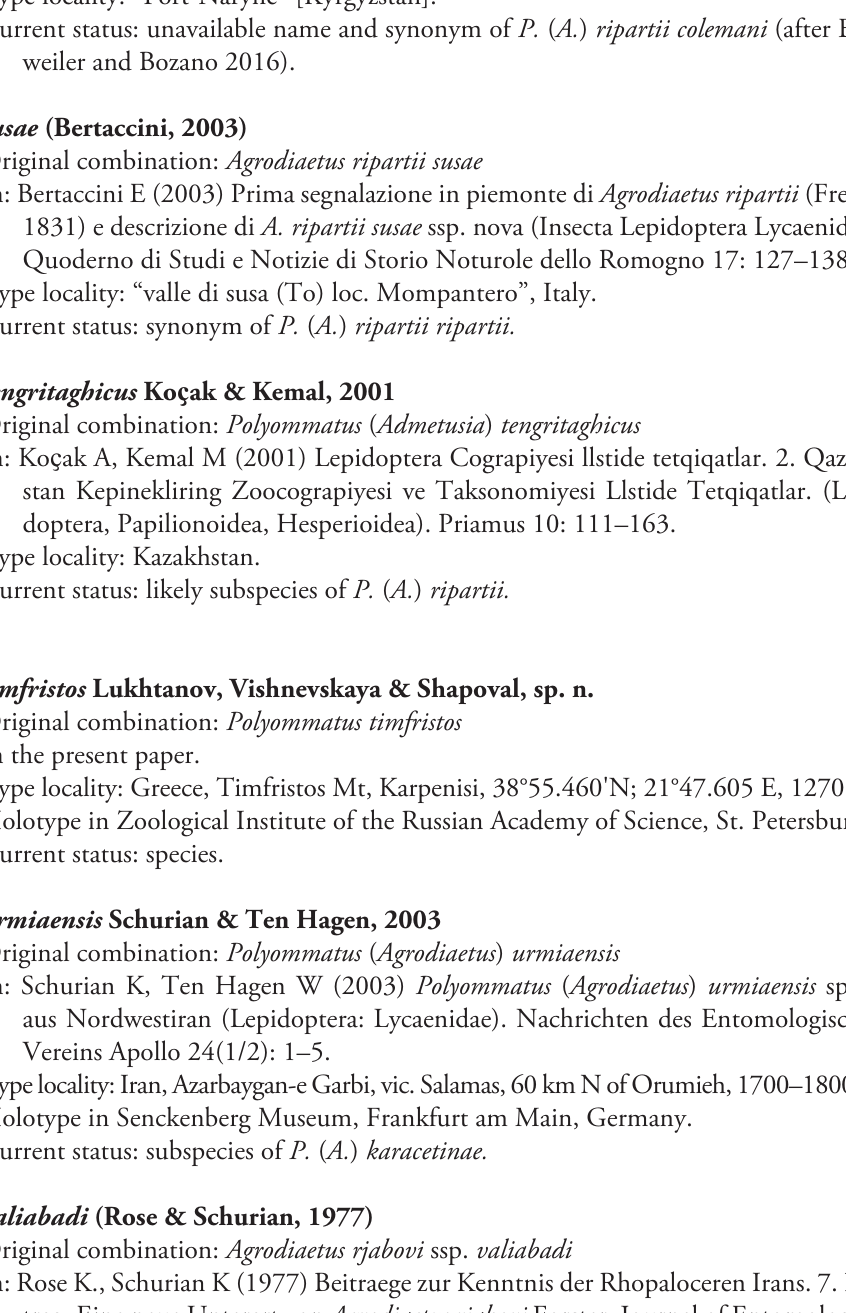
Maria S. Vishnevskaya et al. / Comparative Cytogenetics 10(5): 1–85 (2016) 70 Type locality: “Fort-Naryne”